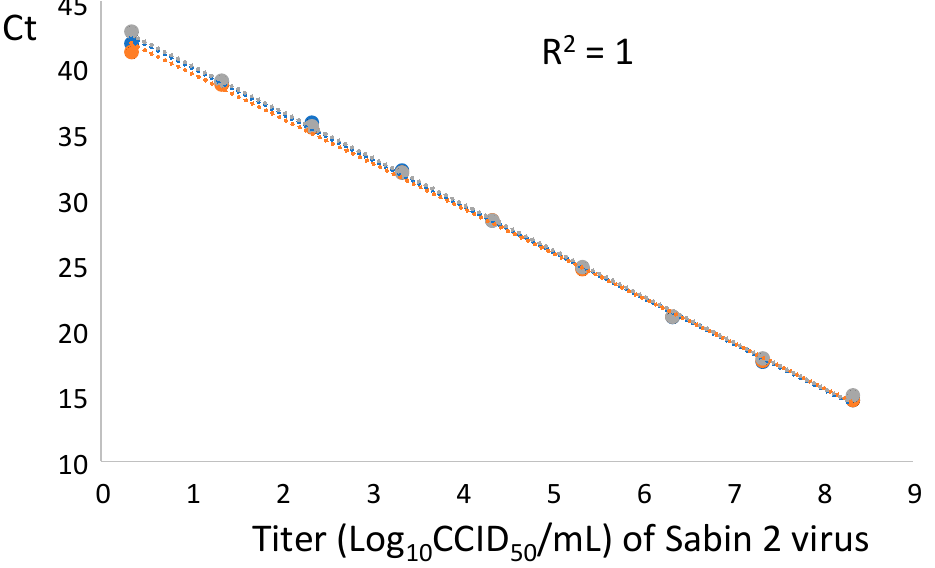
Figure 2. The three repeats of qosRT-PCR analysis (each repeat is presented in one line) of RNA diluted samples: RNA was extracted from Sabin 2 virus (with titer of 8.34 Log 10 CCID 50 /mL), serially diluted 10-times using 10-fold steps and subjected to qosRT-PCR analysis. The R 2 is around 1 for each repeat of the analyzed samples.